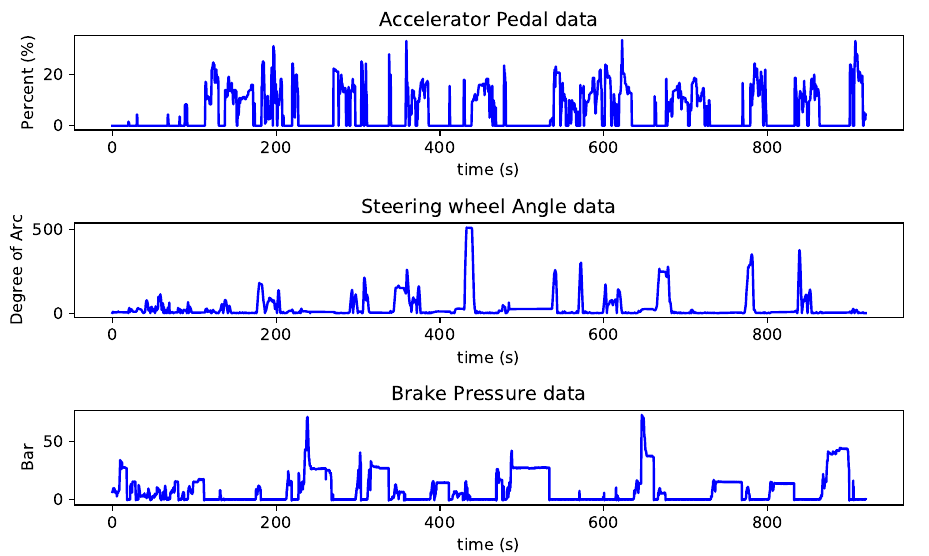
Figure 2. Three vehicle bus data-points are depicted over time. The top figure shows the output of the Accelerator Pedal (AccP) sensor, the middle figure is for the Steering Wheel Angle (SWA) and the bottom figure is showing the output of the Brake Pressure (BP) sensor.